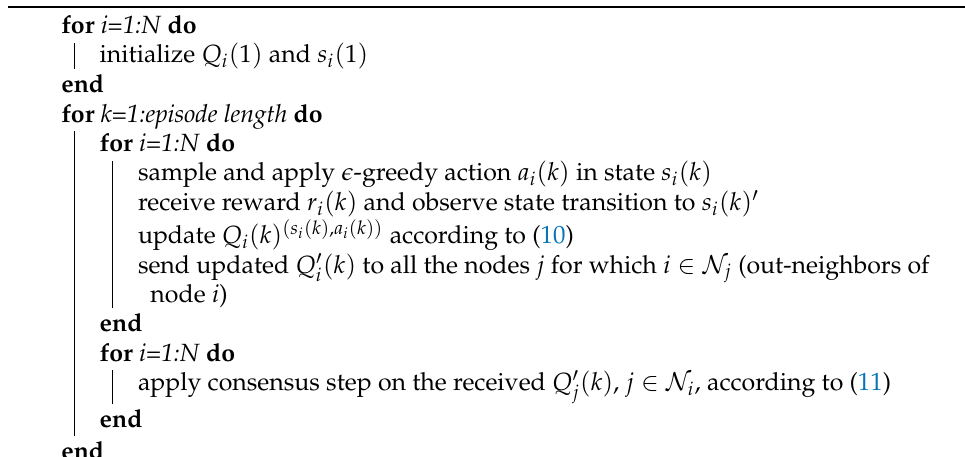
Algorithm 2: Distributed consensus-based Q-learning.